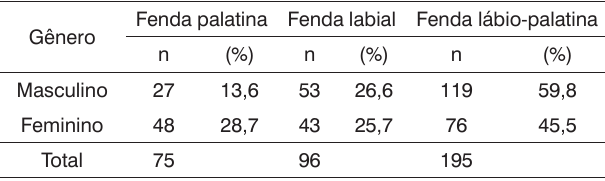
Na Tabela 2 podemos observar a distribuição da FL/P NS de acordo com o gênero. Tabela 2. Distribuição de fenda labial e/ou palatina não sin- drômica de acordo com sua extensão e